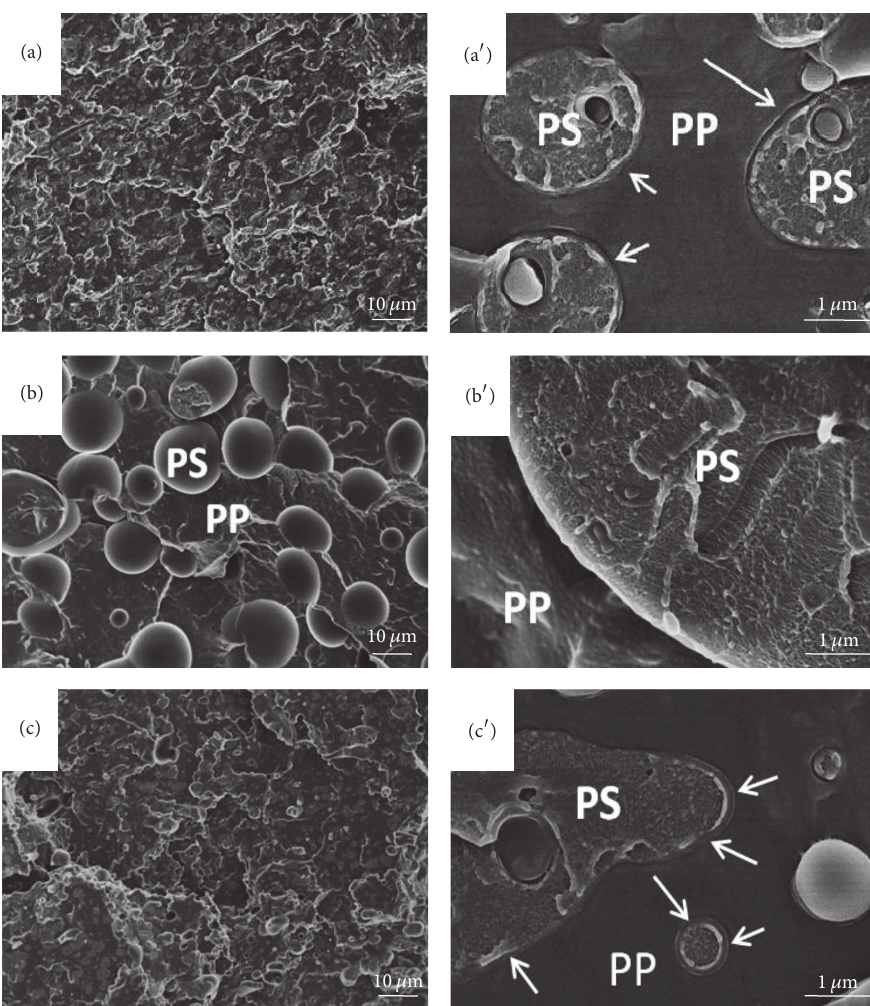
Figure 7: FESEM images showing the phase morphologies of 0.5 wt% aGO in representative composites. [(a) and (a 󸀠 )] aGO/PP/PS; [(b) and (b 󸀠 )] (PS/aGO)/PP; [(c) and (c 󸀠 )]